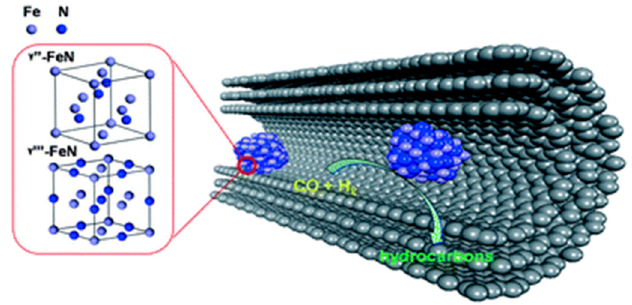
Figure 4. Reproduced from [32], with permission from Royal Society of Chemistry, 2011.